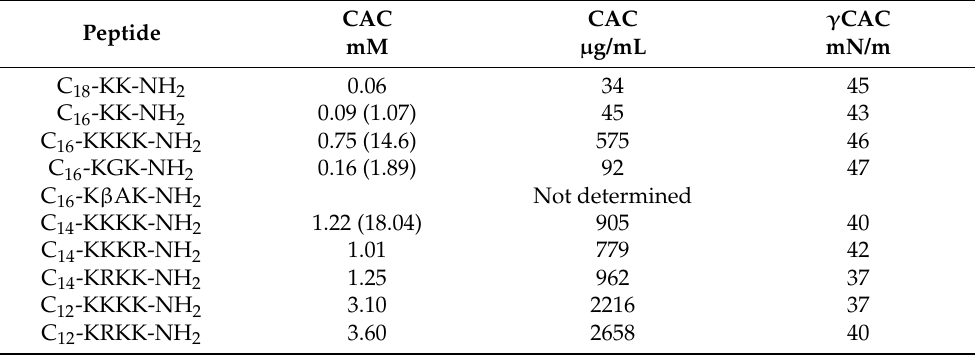
Table 2. Critical micelle concentration and surface tension at CAC measured in a phosphate-buffered solution (pH